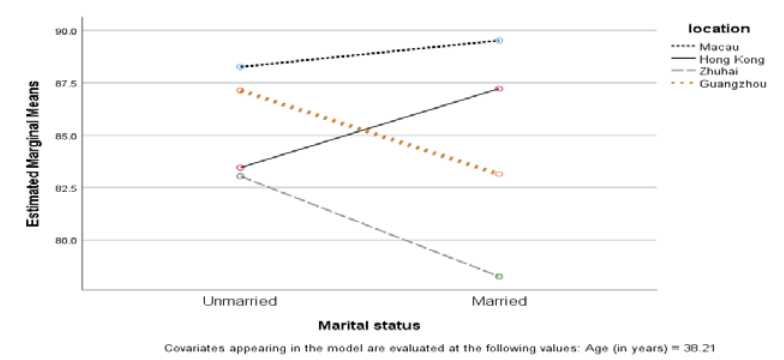
Figure 2. Comparison of Dementia Attitude Scale (DAS) scores among married people and others across four cities.